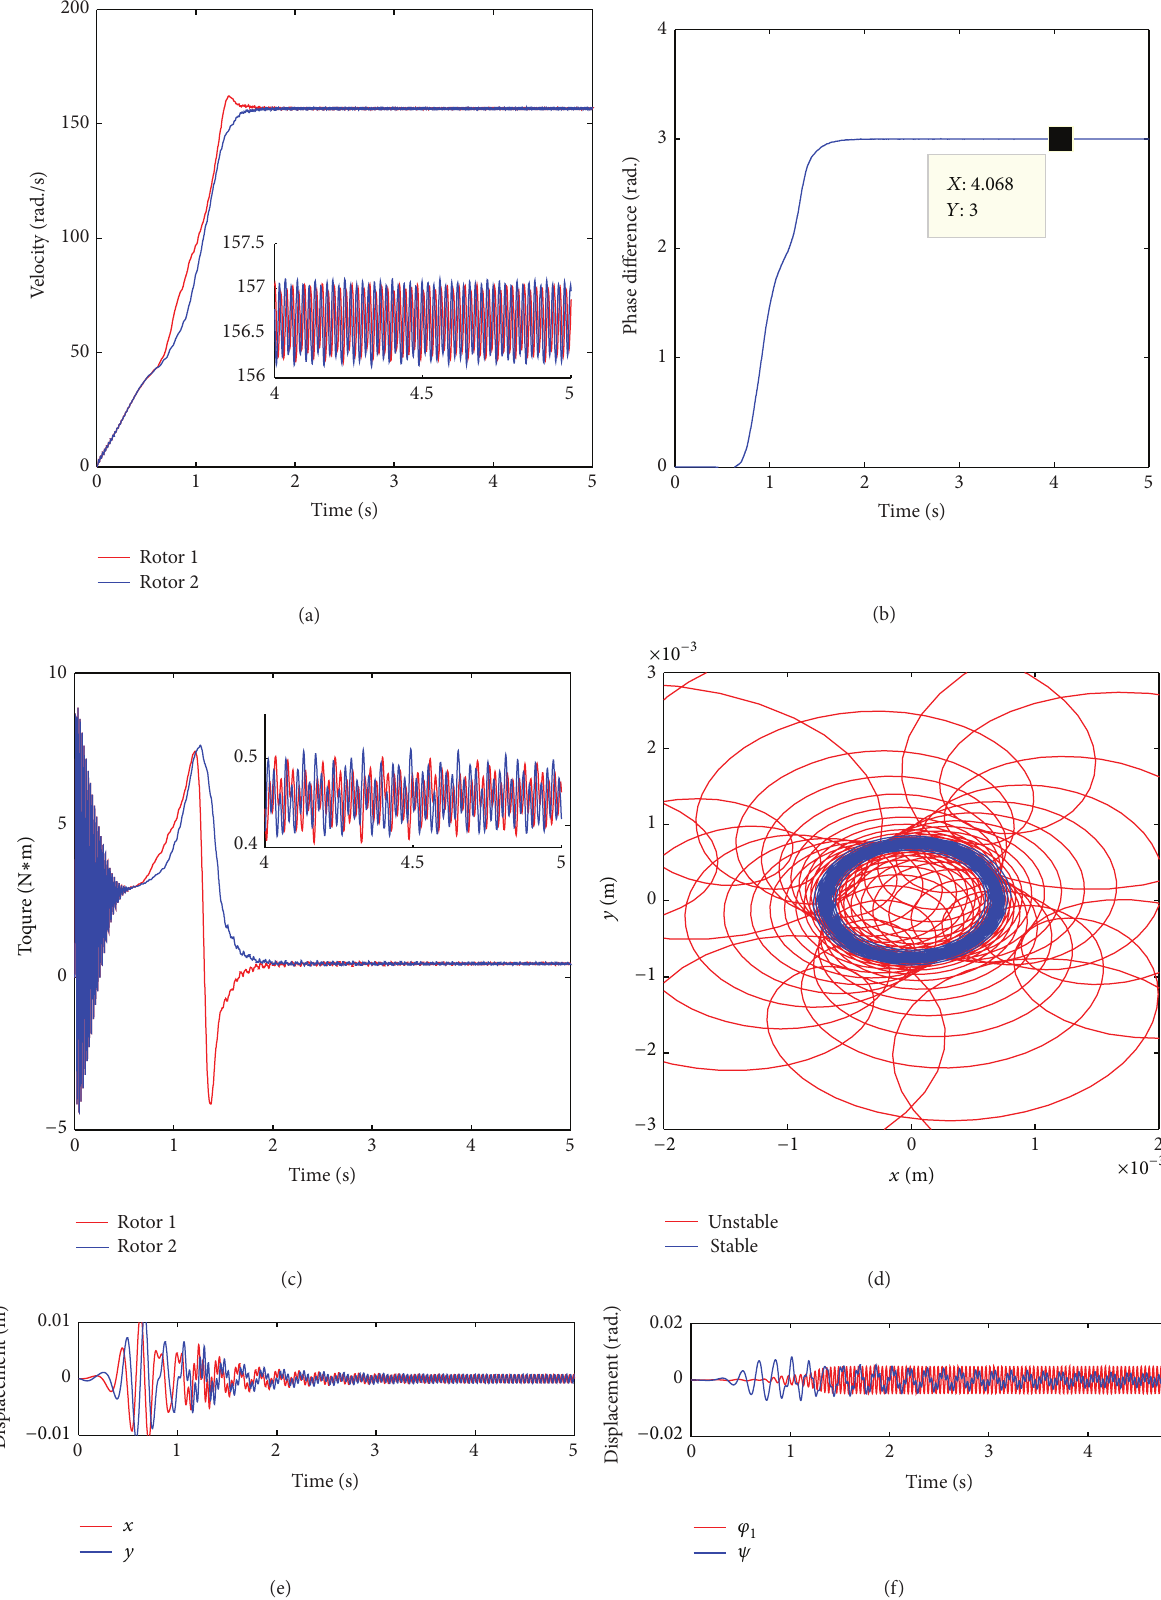
Figure 9: Simulation results for SACWB: (a) rotational velocity, (b) phase difference of the two rotors, (c) torques of the two rotors, (d) trajectory of mass center of the vibrobody, (e) displacement responses of the vibrobody in 𝑥 - and 𝑦 -directions, and (f) displacement responses of the vibrobody in 𝜑 1 - and 𝜓